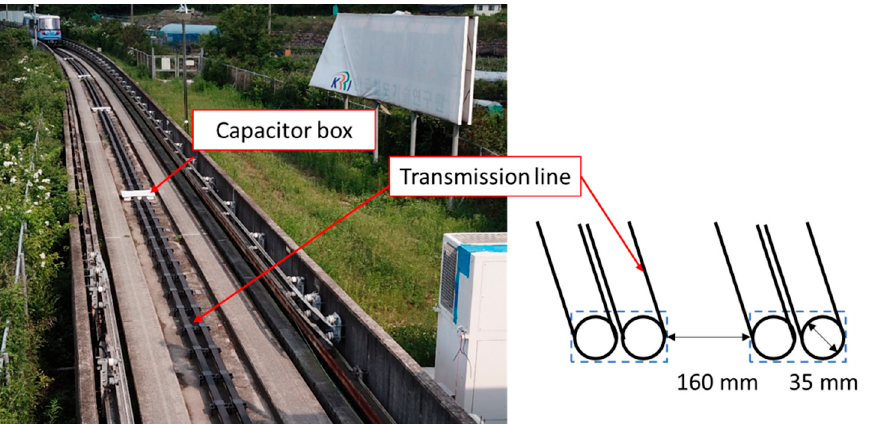
Figure 2. Structure of power line.